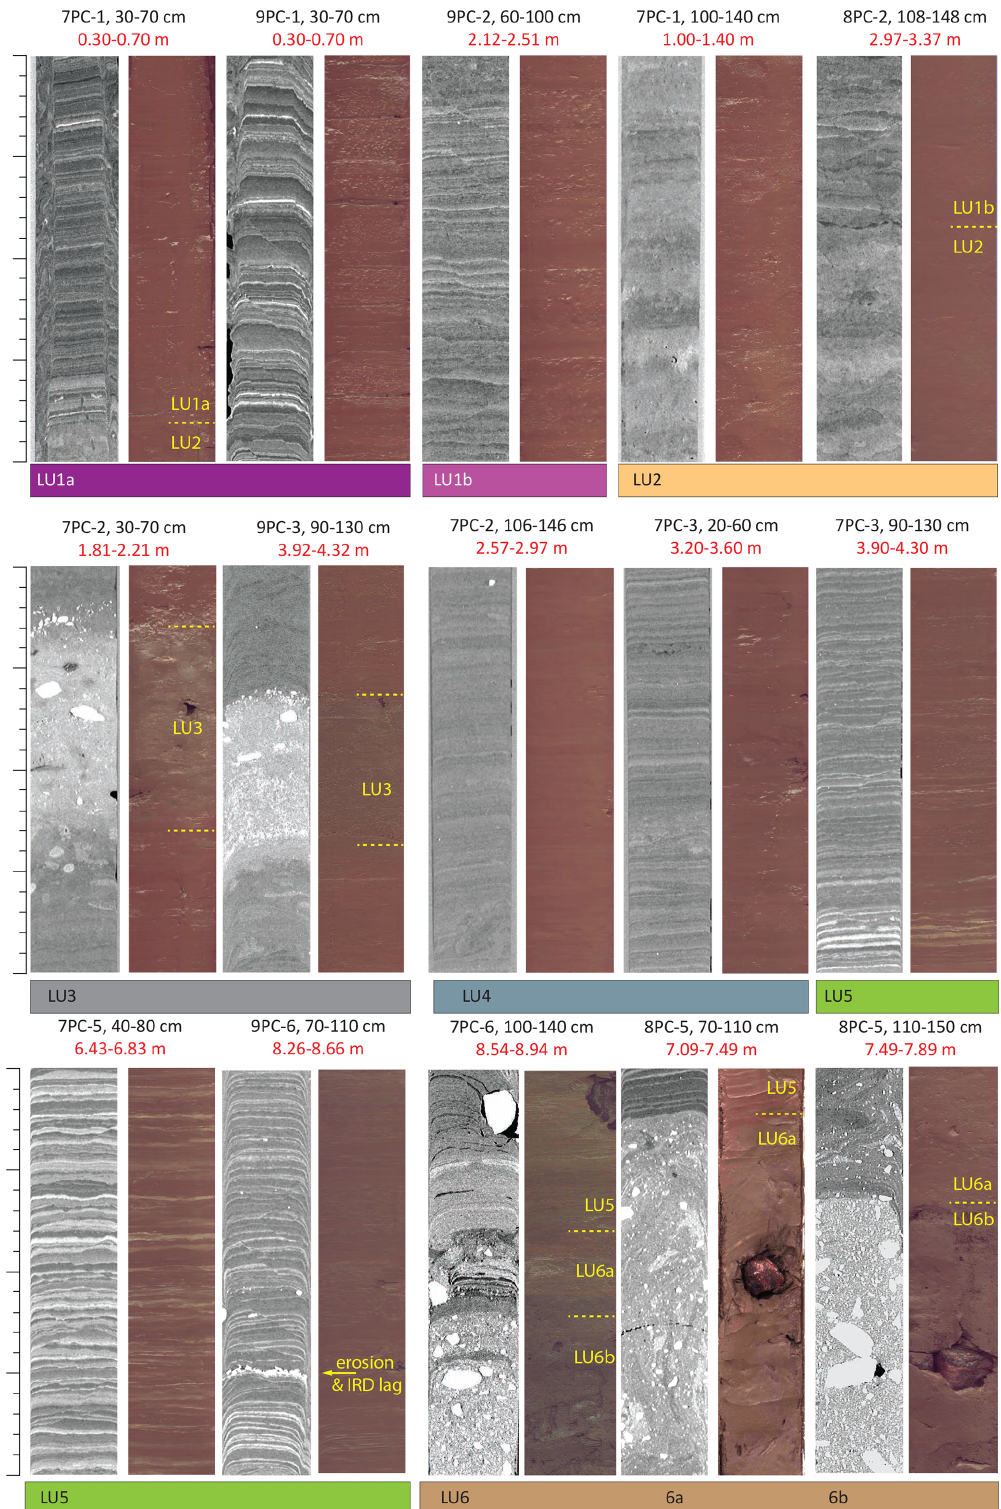
Figure 7. Examples of CT images and color photographs representative of the six lithologic units. The vertical scale for each image is a constant 50cm. The structures seen on the CT images and the color photographs are not identical because the imaging planes are slightly different. The CT images are representative 2-dimensional slices of the core interior, whereas the photos show the surface of split cores. White in CT images corresponds to higher density zones and black to lower density zones. Composite depths for each interval are given in